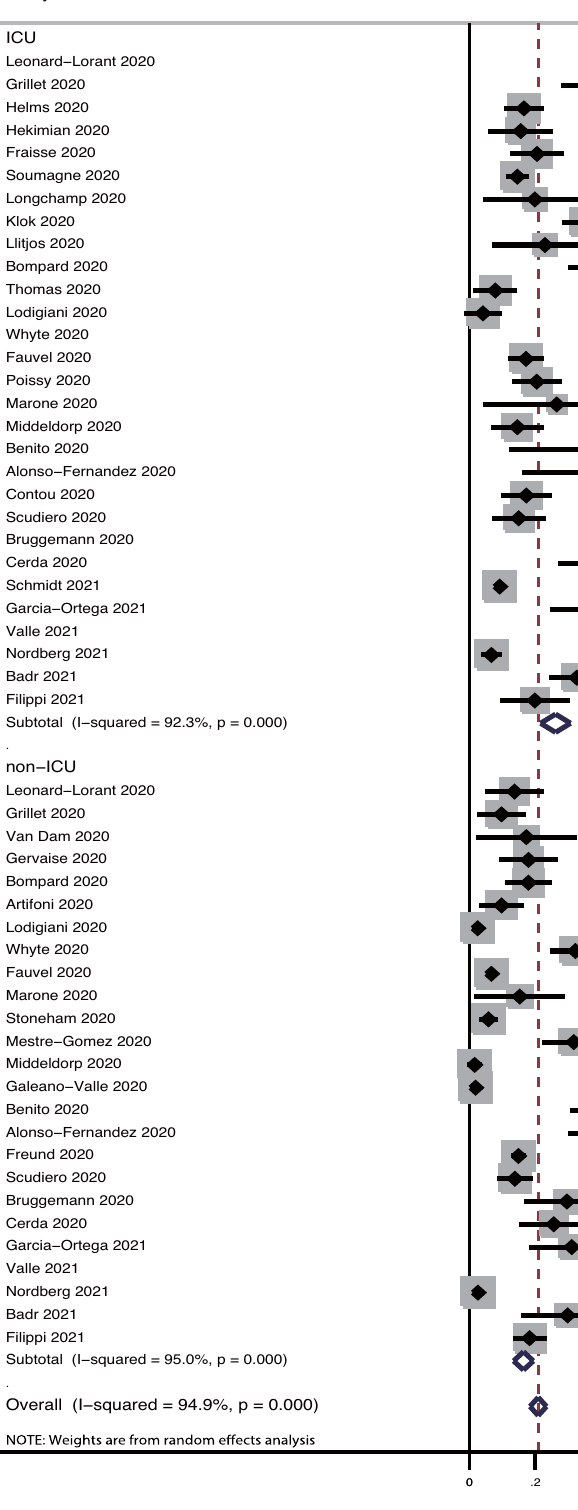
Fig 2. The pooled incidence of pulmonary embolism in COVID-19